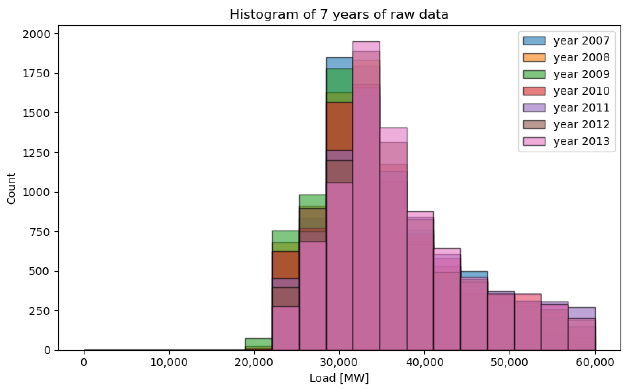
Figure 10. Histogram of hourly load of Texas.